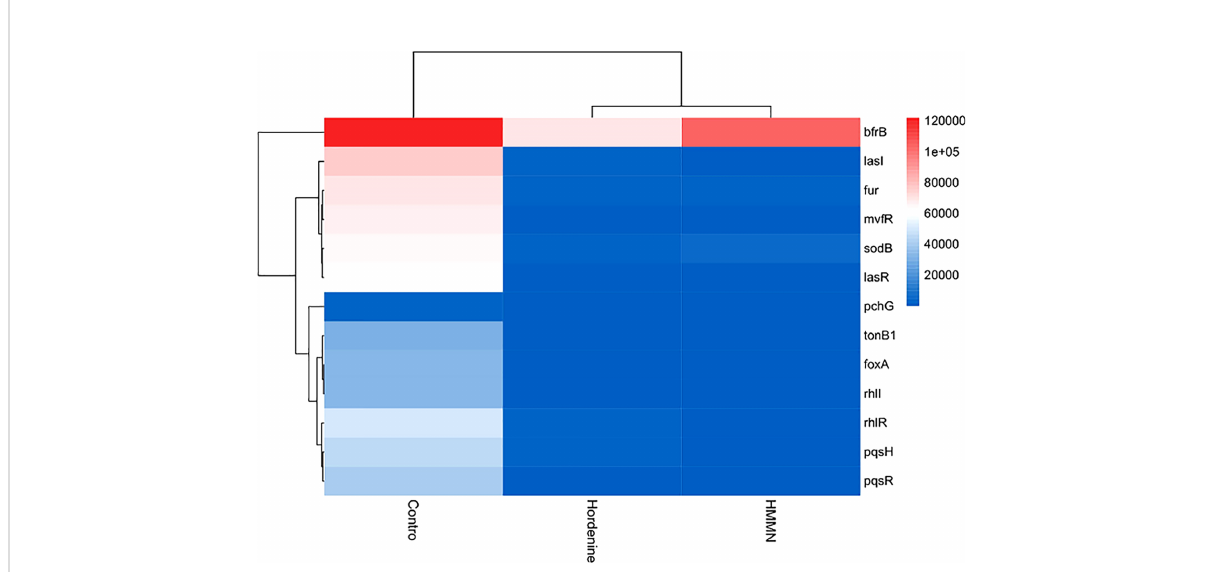
FIGURE 6 The hierarchical clustering maps. The hierarchical clustering maps in different treatments (hordenine and HMMN). The red side means upregulation, and the blue side means